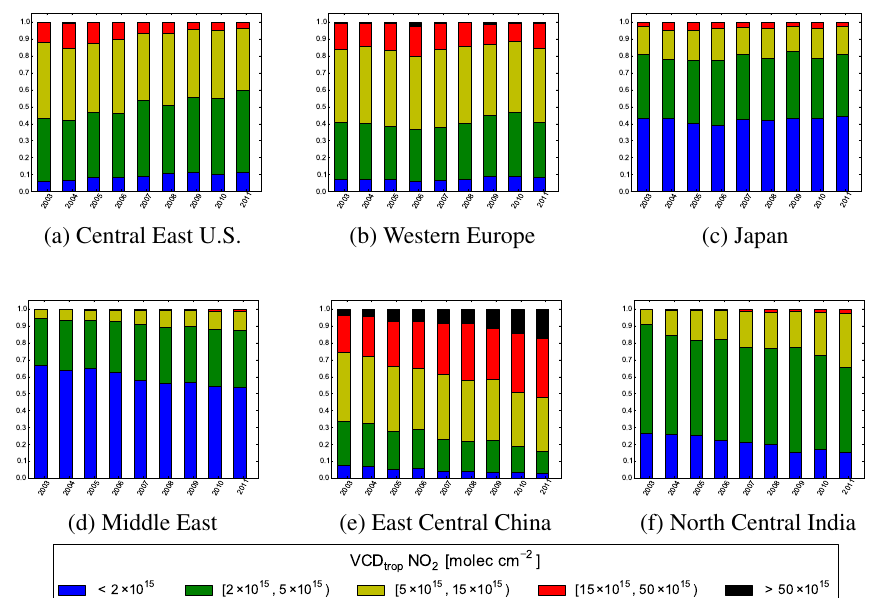
Fig. 5 : Histogram of VCD trop NO 2 from SCIAMACHY over the regions from Fig. 3 for the years 2003-2011. The plot shows the relative counts of background (blue), moderately polluted (green), polluted (yellow), very polluted (red), and extremely polluted (black) 1° × 1°grid cells per region.